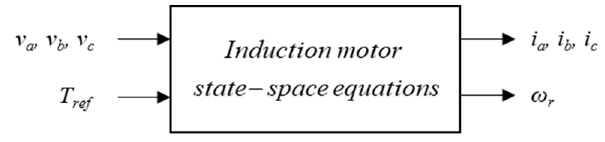
Figure 5. Induction motor dynamic model of the simulation tests.